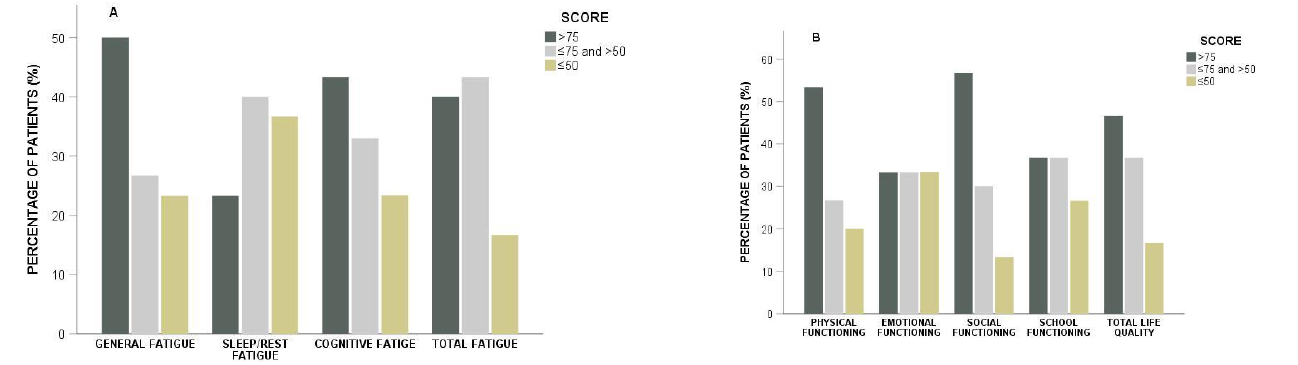
Figure 1. Percentage of patients with scores > 75, ≤ 75; and >50, ≤ 50 on ( A ) fatigue and ( B ) health- related quality of life (HRQoL), and their subcategories.